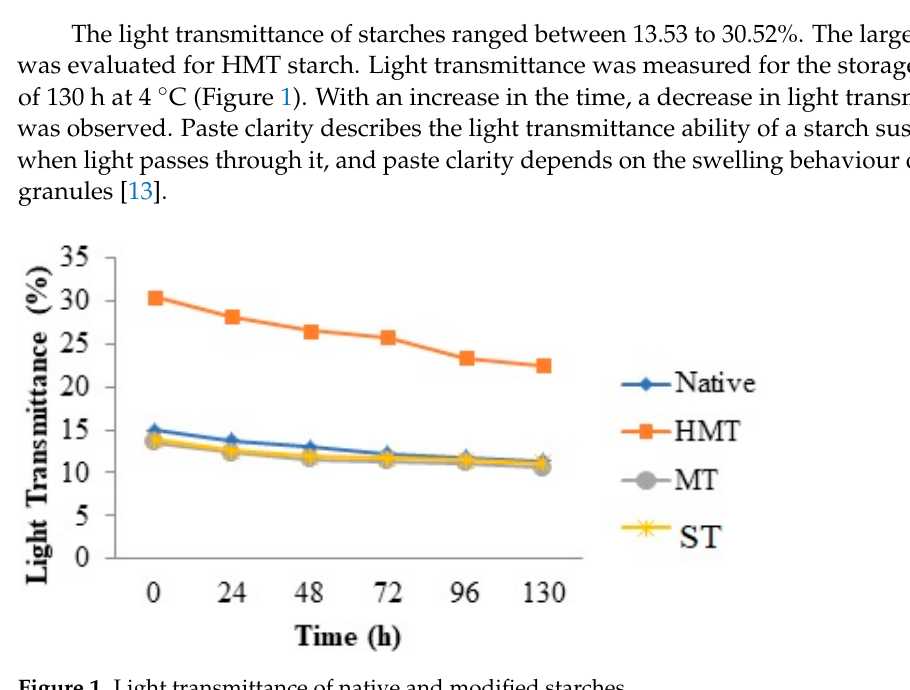
Table 1. Physicochemical properties of native and modified starches.